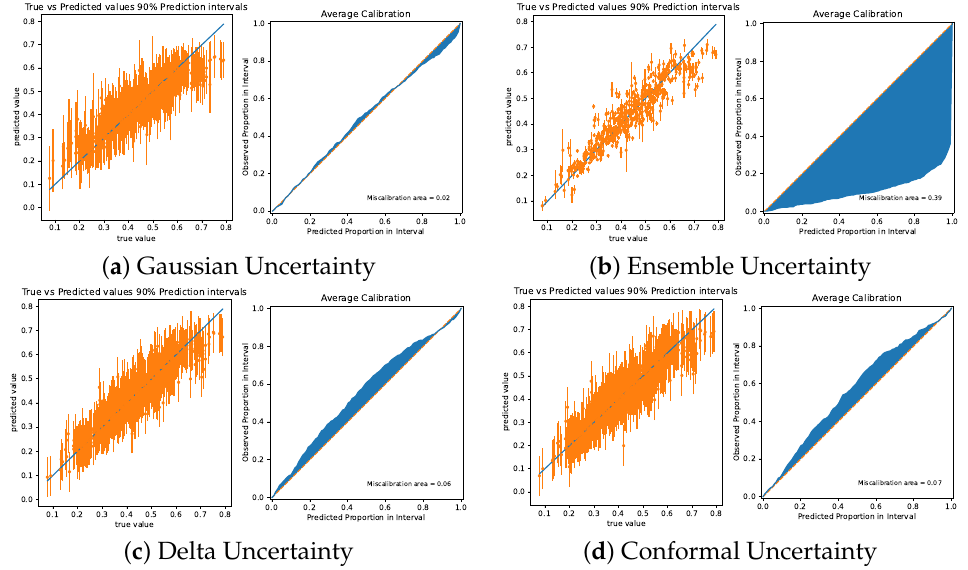
Figure 5. Different uncertainty calibration curves for the GPR model. Other models show similar trends, with the Tensorflow ANN loss function method behaving similarly to ensemble